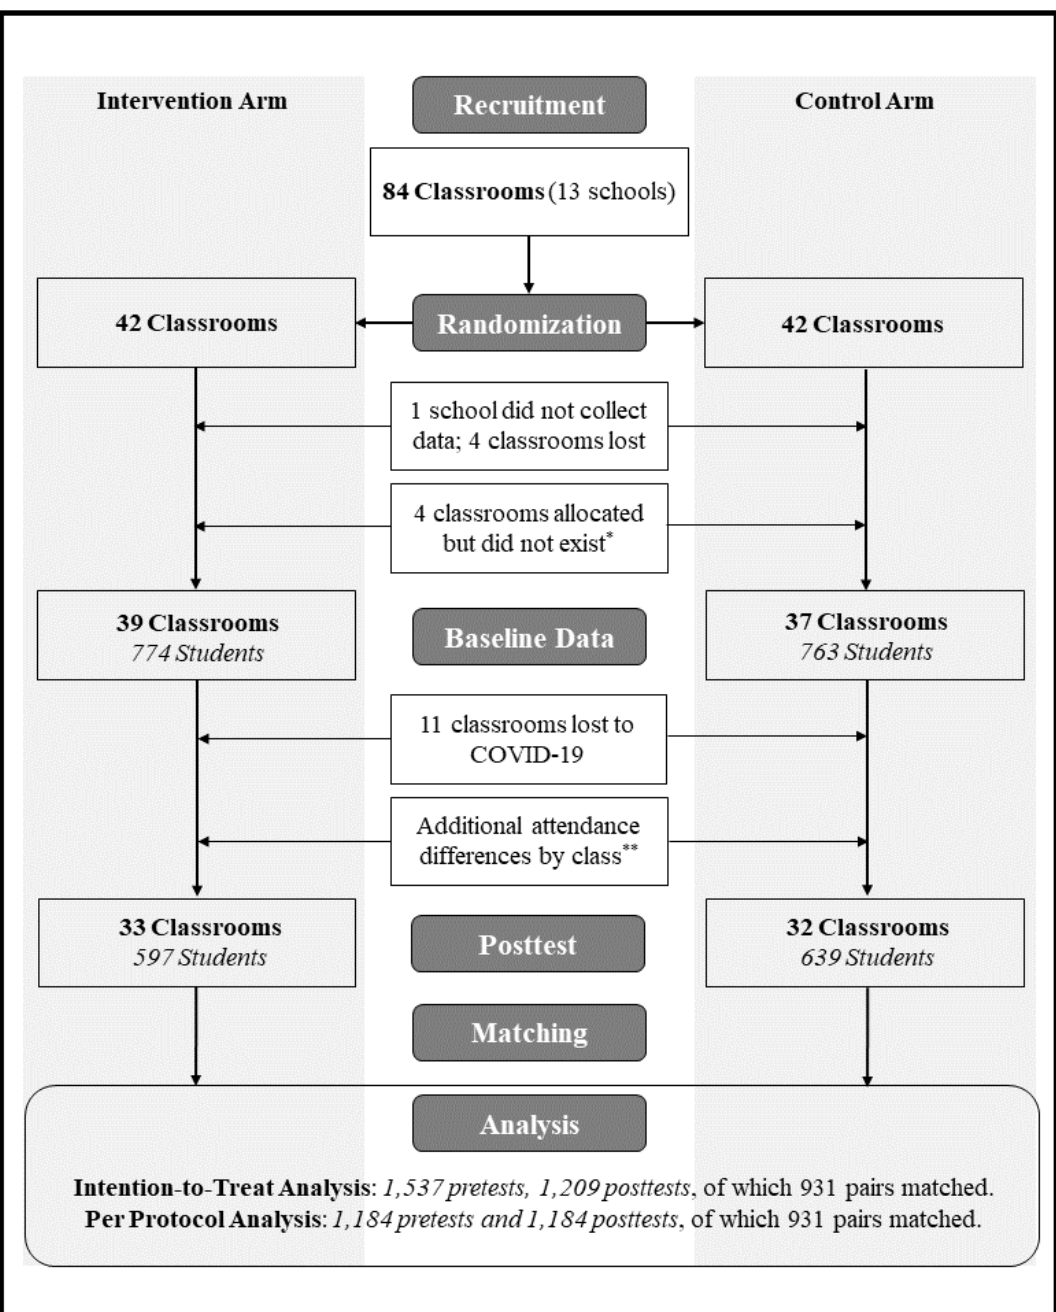
Figure 1. Consort flow diagram. *Classroom count was provided by schools and used to randomize clusters. When arriving to deliver interventions, it was discovered that 4 classrooms that had been allocated did not exist (n=3 schools). **Attendance differences by cluster are provided in supplemental material for the matching procedure paper